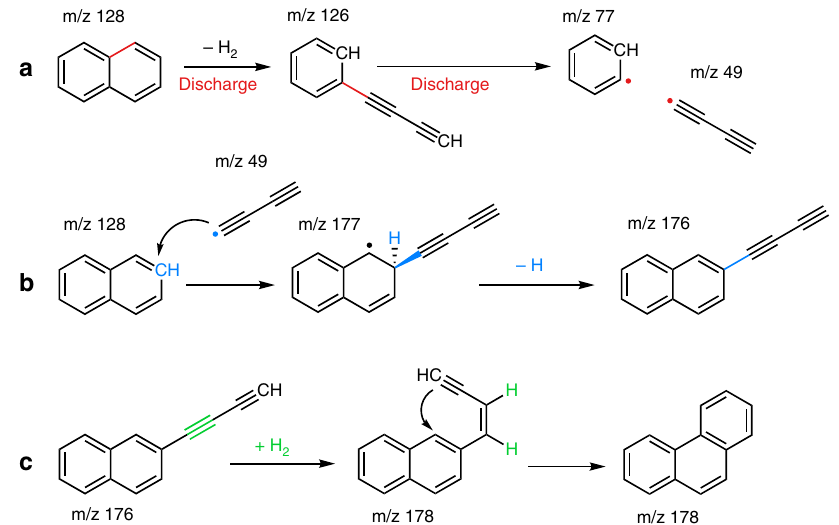
Fig. 4 Proposed reaction mechanism of the formation of phenanthrene and intermediates. a Reaction mechanism of the formation and subsequent fragmentation of diacetylenebenzene ( m / z = 126). b The diacetylene that is created in step a can further react to form diacetylene – naphthalene ( m / z = 176) which is a likely precursor for the formation of phenanthrene ( c